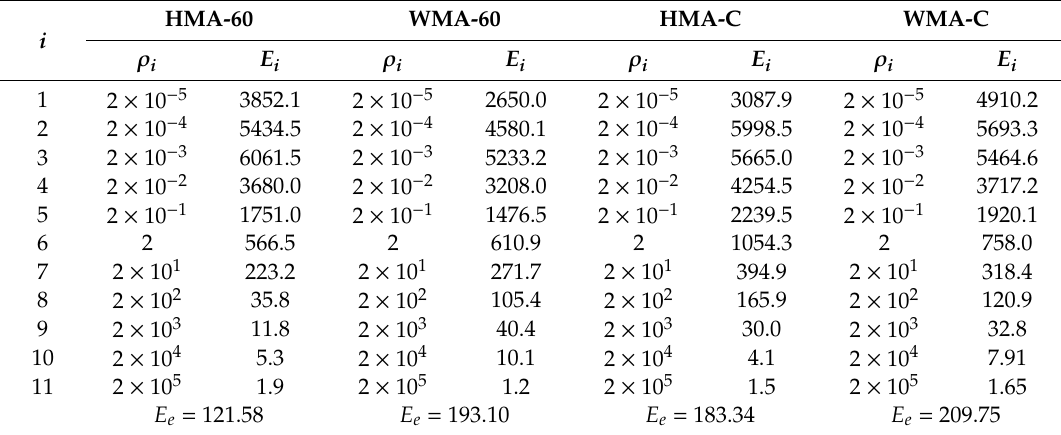
Table 9. Discrete relaxation spectrum of crumb rubber-modified asphalt mixture [24].